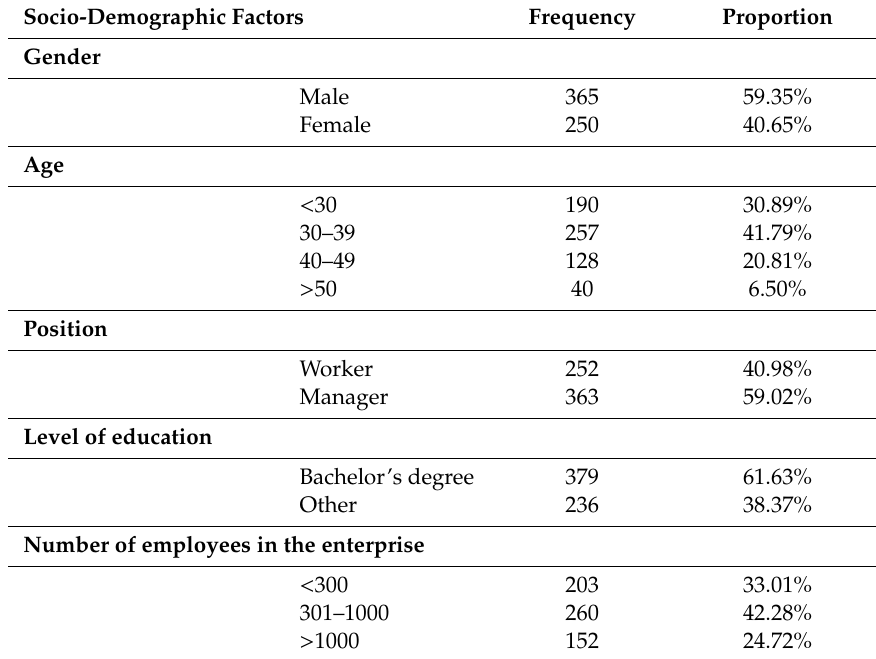
Table 2. Sample demographics ( N =